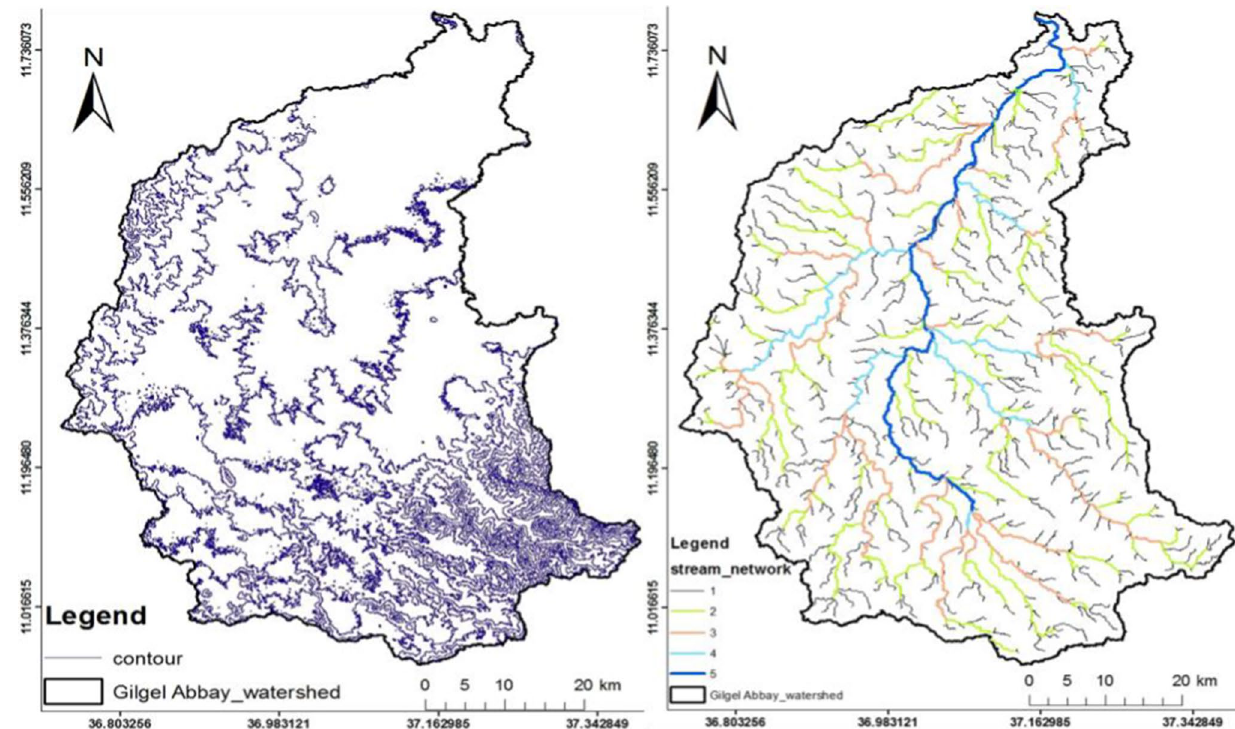
Fig. 3 Contour line and stream networks of the study